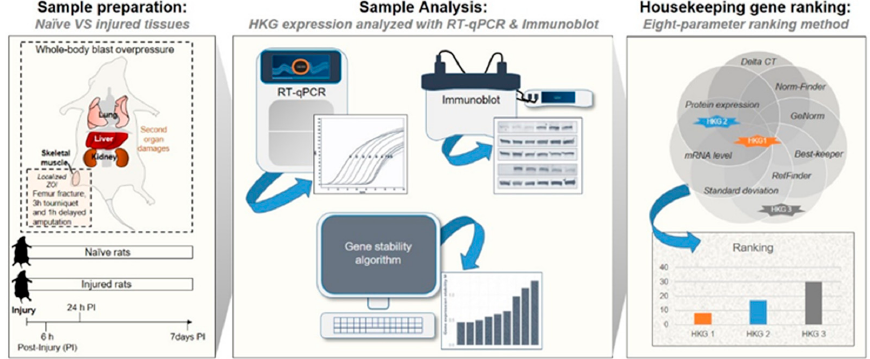
Figure 1. Method and protocol flow design.